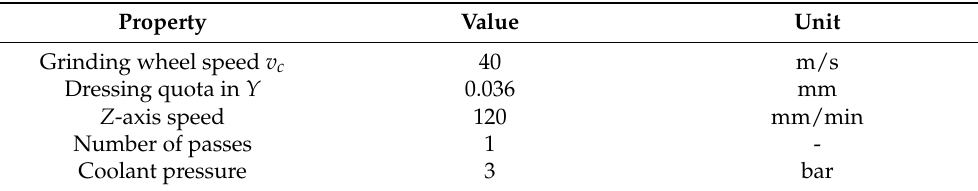
Table 3. Dressing Table 3. Dressing Parameters.